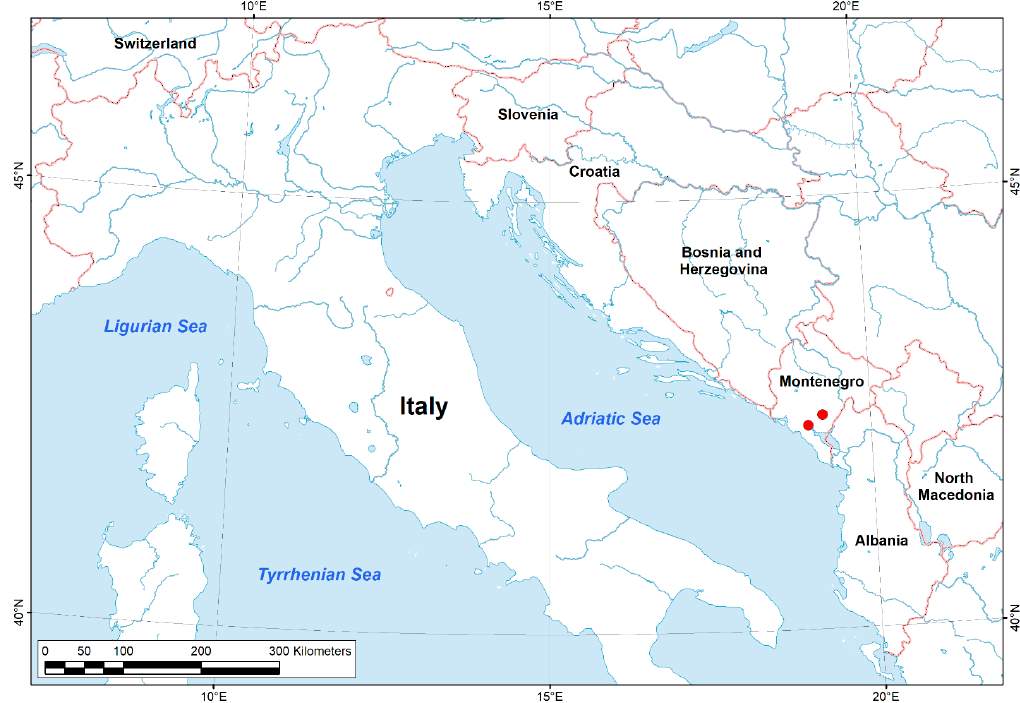
Figure 6. Distribution of Unio carneus stat. rev. Table 2. Species richness and number of collected specimens of freshwater mussels in Montenegro.